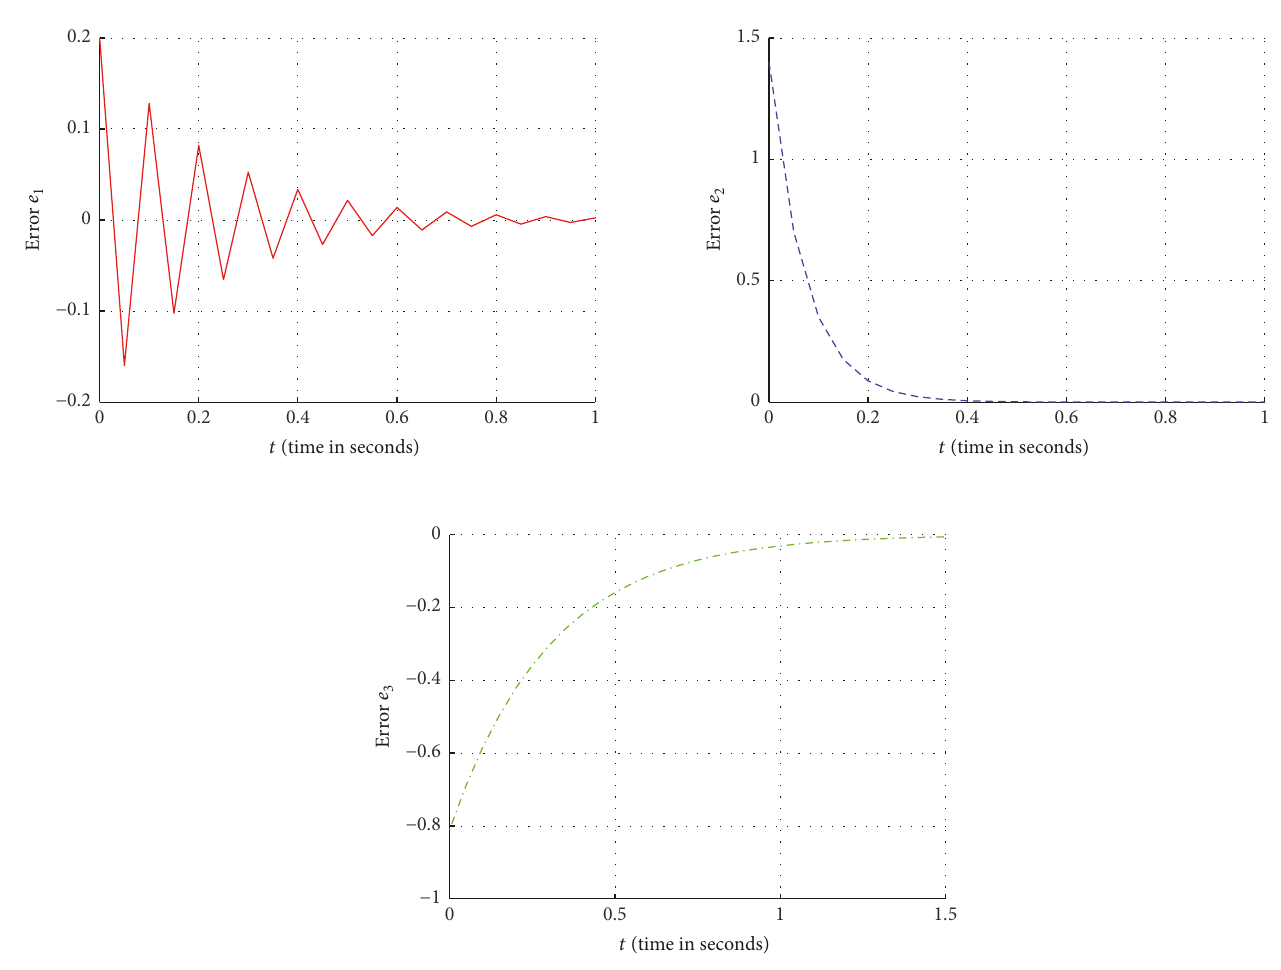
Figure 6: Time evolution of the synchronization errors 𝑒 1 , 𝑒 2 , and 𝑒 3 between master system (34) and slave system (36).